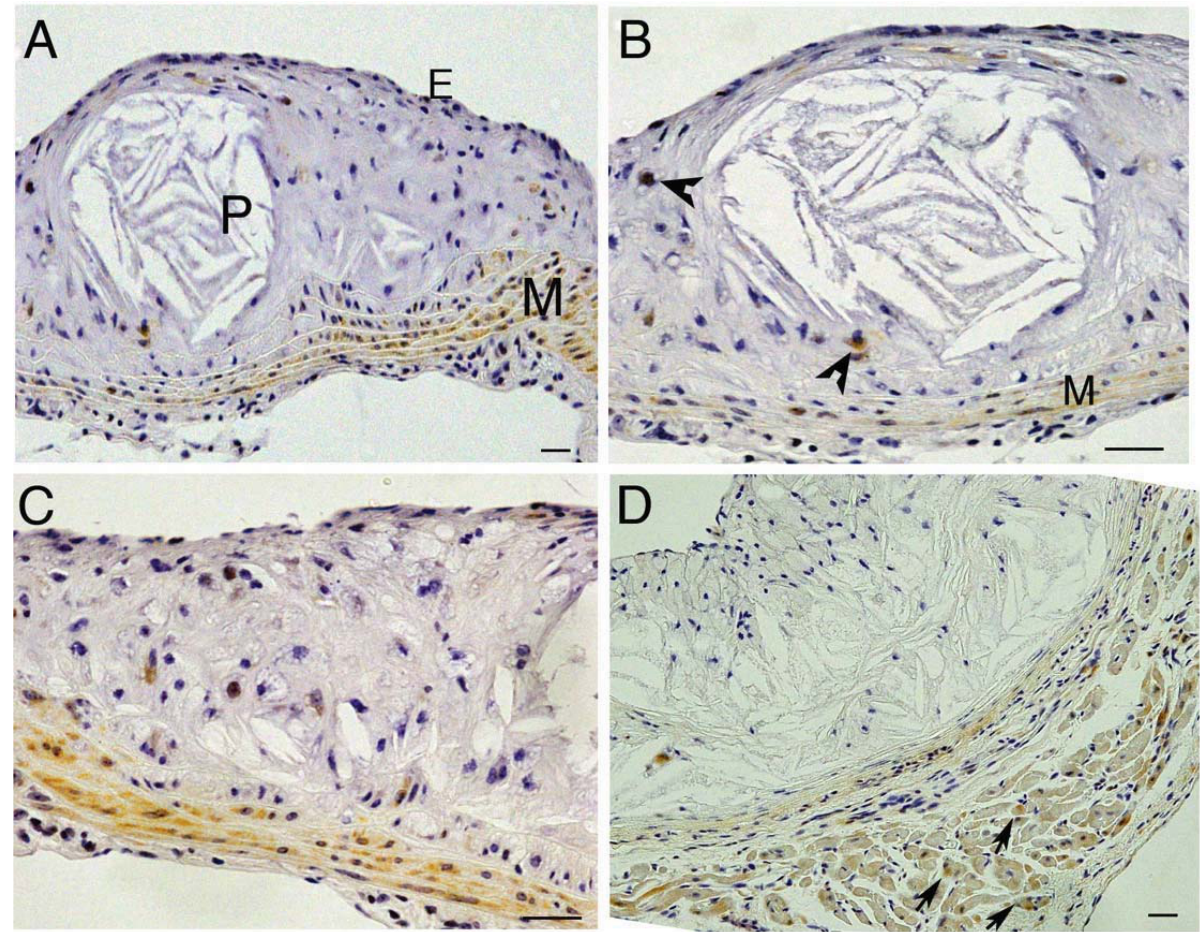
Figure 3. Tribbles 2 (trb2) expression in experimental mouse atherosclerosis. A